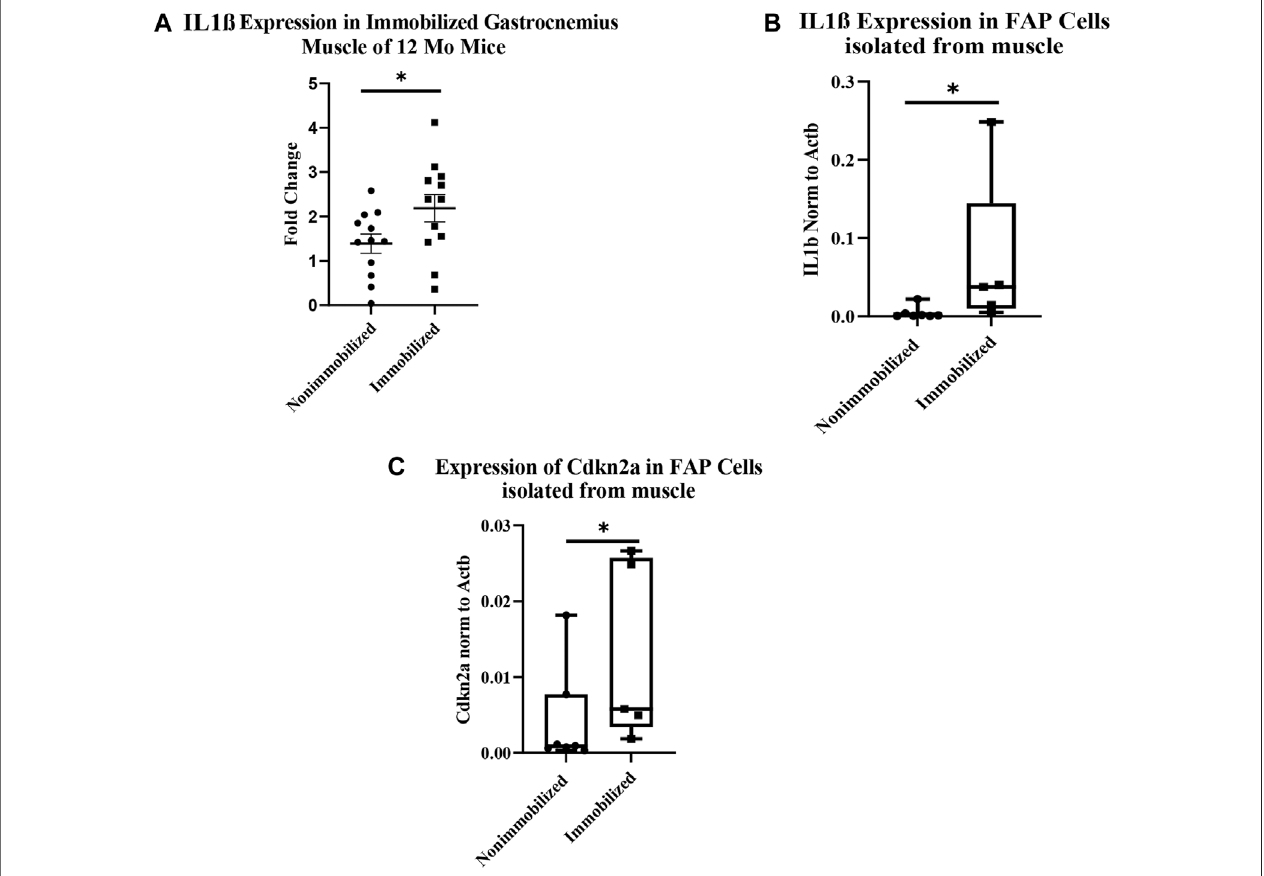
FIGURE 4 | Muscle atrophy increases IL-1 β expression and induces senescence in FAP cells. (A) IL-1 β expression increased in immobilized muscle compared to nonimmobilizedmuscle( p < 0.05) (B) ddPCRresultsonthesamplesusedforRNAseqvalidatestheupregulationofIL-1 β ( p < 0.05). (C) ddPCRresultsshowasigni fi cant increase in Cdkn2a expression in FAP cells isolated from immobilized muscle compared to nonimmobilized muscle ( p < 0.05).